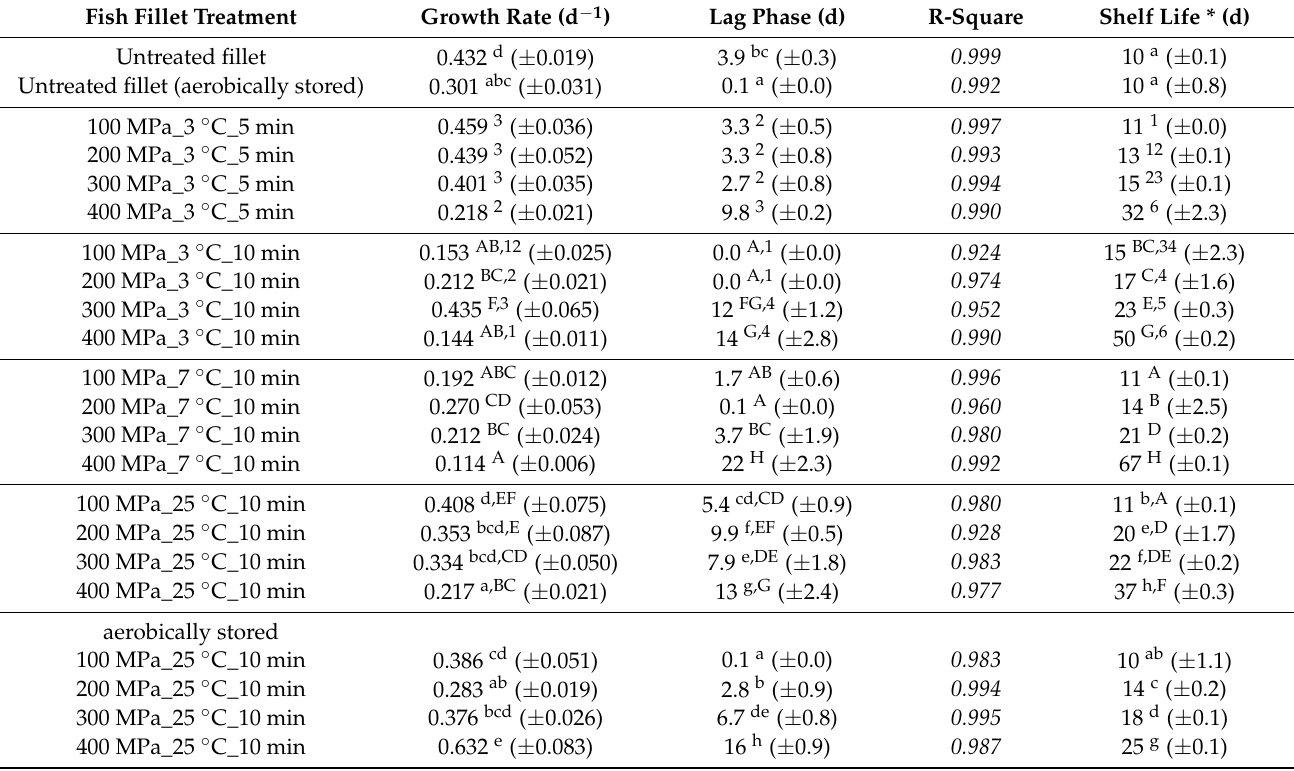
Table 2. Estimated microbial growth parameters and shelf life of untreated and HP-treated vacuum- packed sea bass fillets based on TVC values as the dominant spoilage